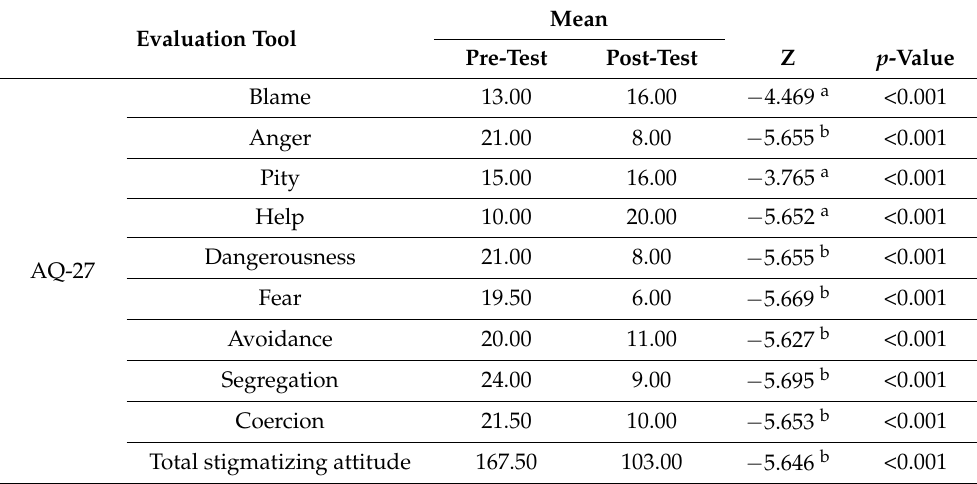
Table 2. Pre- and post-test comparisons in the group of people without disabilities. Evaluation